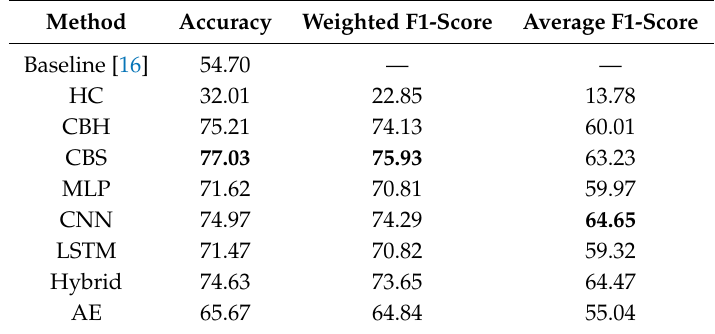
Table 9. Thirty-fold Leave-One-Subject-Out cross validation performance metrics (in percent) of the different feature extraction models on the UniMiB-SHAR